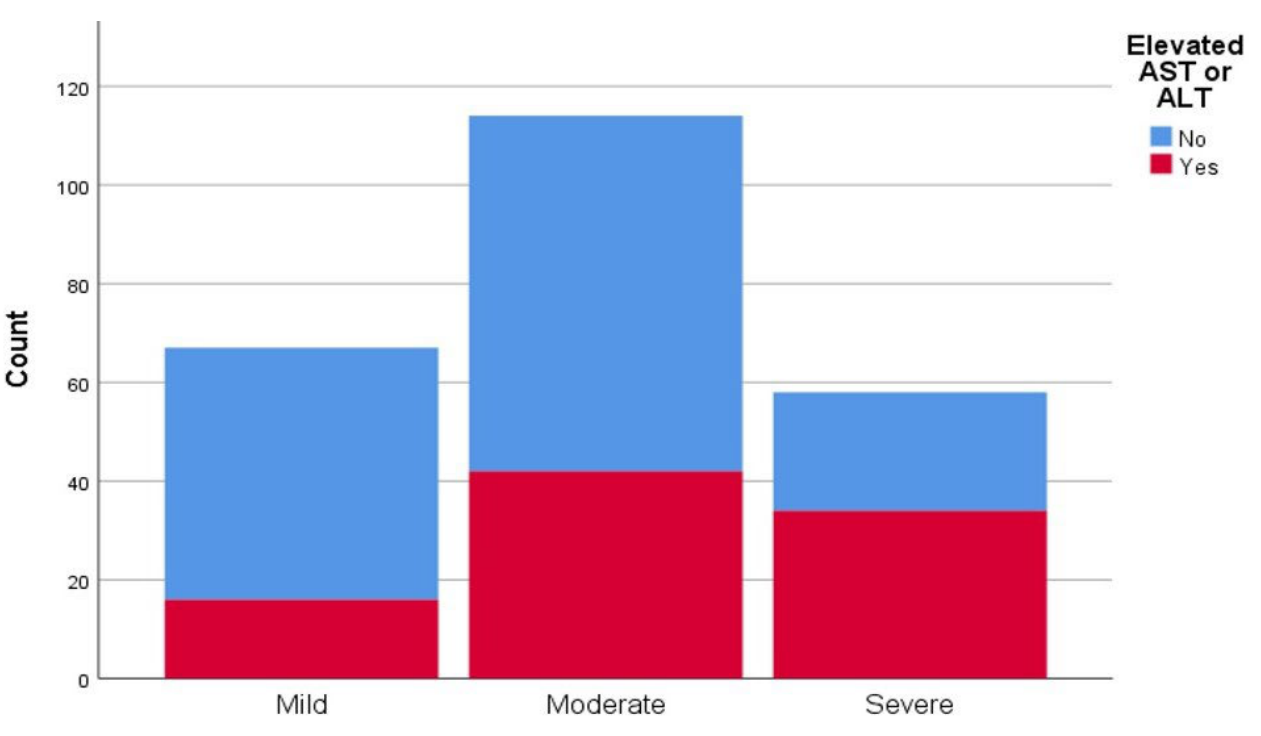
Figure 1. Representation of computed tomography (CT) scan severity score of interstitial pneumonia in patients with and without elevated liver transaminases (aspartate aminotransferase (AST), alanine aminotransferase (ALT) .